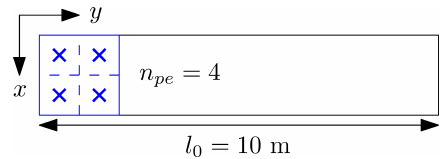
Figure 8. Initial geometry of the